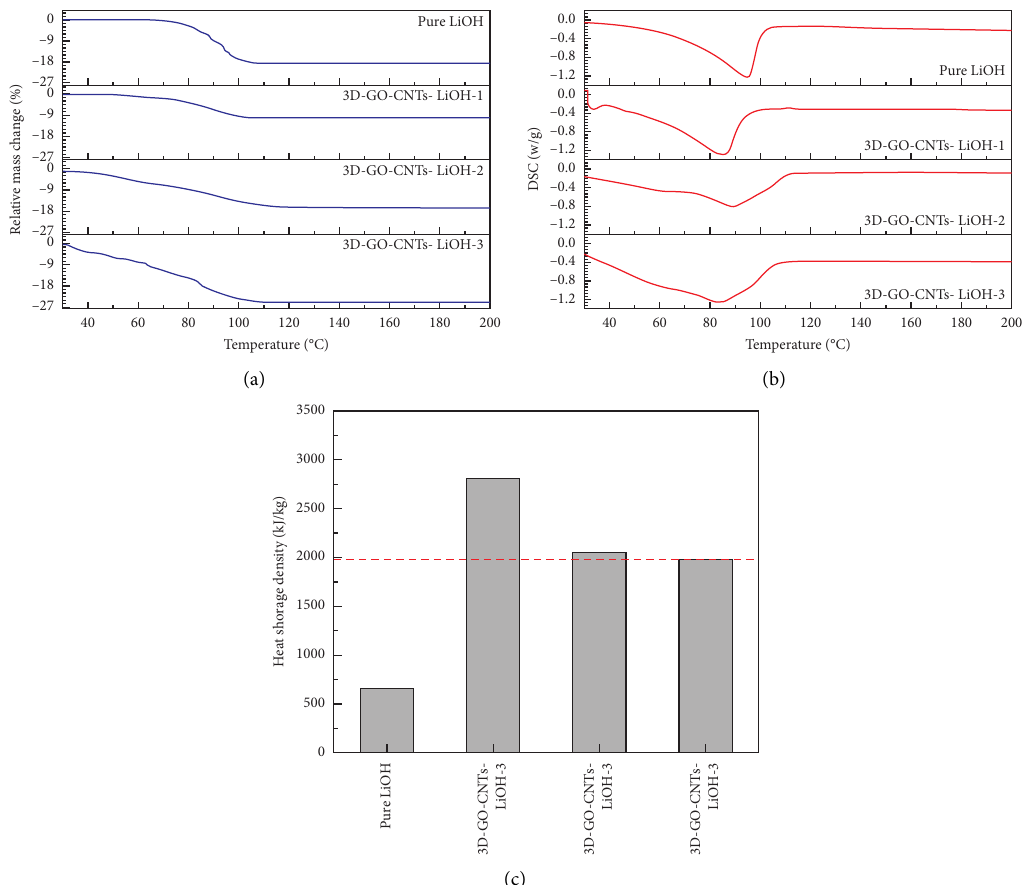
Figure 7: TG-DSC test of LiOH, 3D-GO-CNTs-LiOH-1, 3D-GO-CNTs-LiOH-2, and 3D-GO-CNTs-LiOH-3 after hydration for 1h: (a) TGA; (b) DSC; (c) calculated heat storage density.